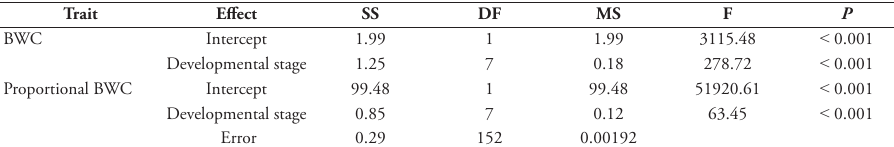
Table 1. Summary statistical results from a one-way ANOVA showing the effects of developmental stage on BWC and proportional BWC in S. frugiperda . SS = sums of squares, DF=degrees of freedom, BWC=body water